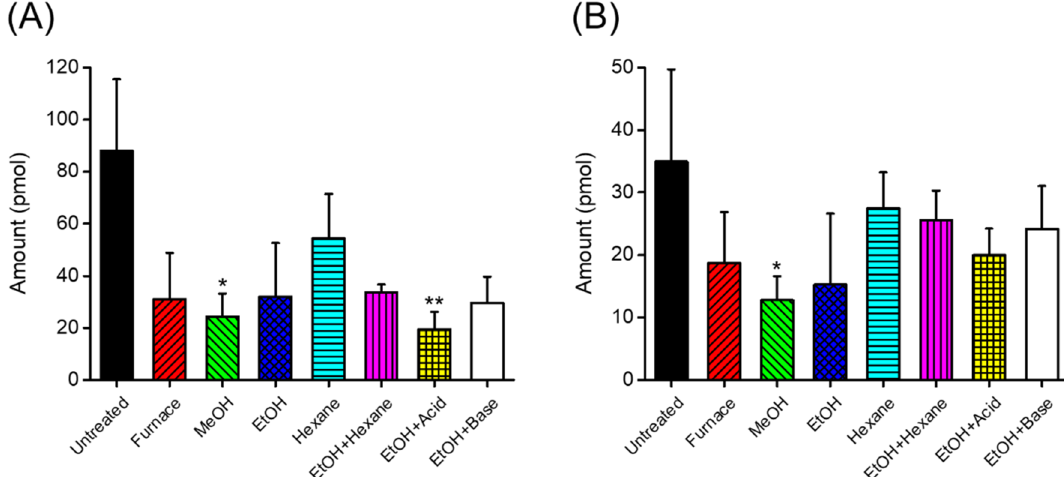
Figure 2. A comparison of the amount of exogenous ( A ) PA and ( B ) SA extracted from GLASSCO glass tubes with various pretreatment methods using different solvents. Data are shown as the mean ± standard deviation (SD) ( n = 6). Asterisks denote statistically significant differences compared with untreated by the Dunn’s post hoc test (* P < 0.05, ** P < 0.01, and *** P < 0.001,